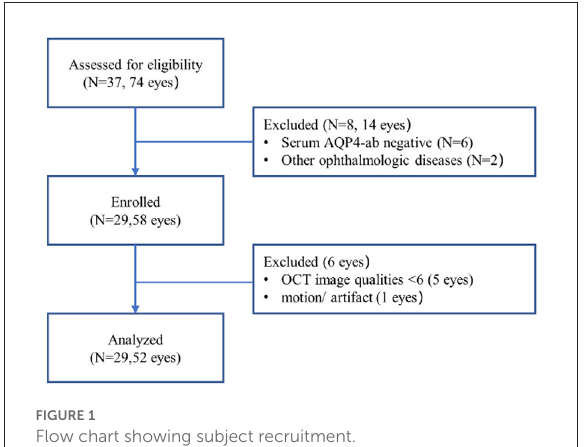
FIGURE1 Flow chart showing subject recruitment.